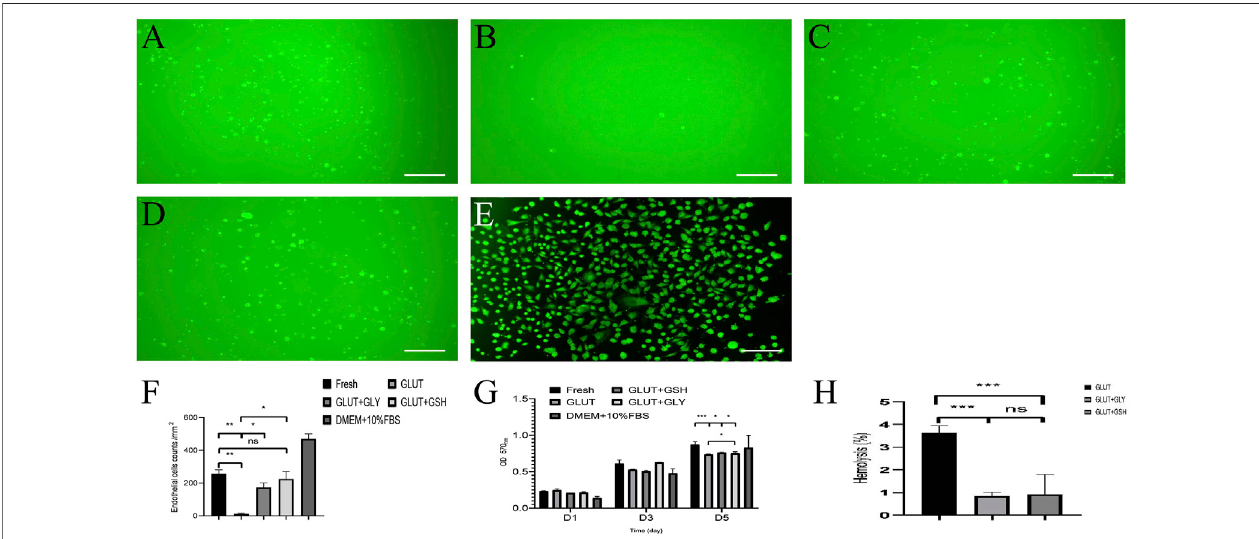
FIGURE 5 | Cytocompatibility of BPs in vitro , A-E is the cell fl uorescence staining of Fresh-BP (A) , GLUT-BP (B) , GLUT + GLY (C) , GLUT + GSH (D) , and DMEM+10%FBS (E) by 6-CDCFDA after 5 days of culture on the BPs surface respectively. (F) is the count of endothelial cells of BPs. The cell proliferation rate (n = 4, meanvalues±s.d.)ofEAHY926cellsweredeterminedusingtheMTTassaykit (G) . (H) isthehemolysispercentageofBPs( n =4; p p < 0.05; pp p < 0.01; ppp p < 0.001;ns represents no signi fi cant